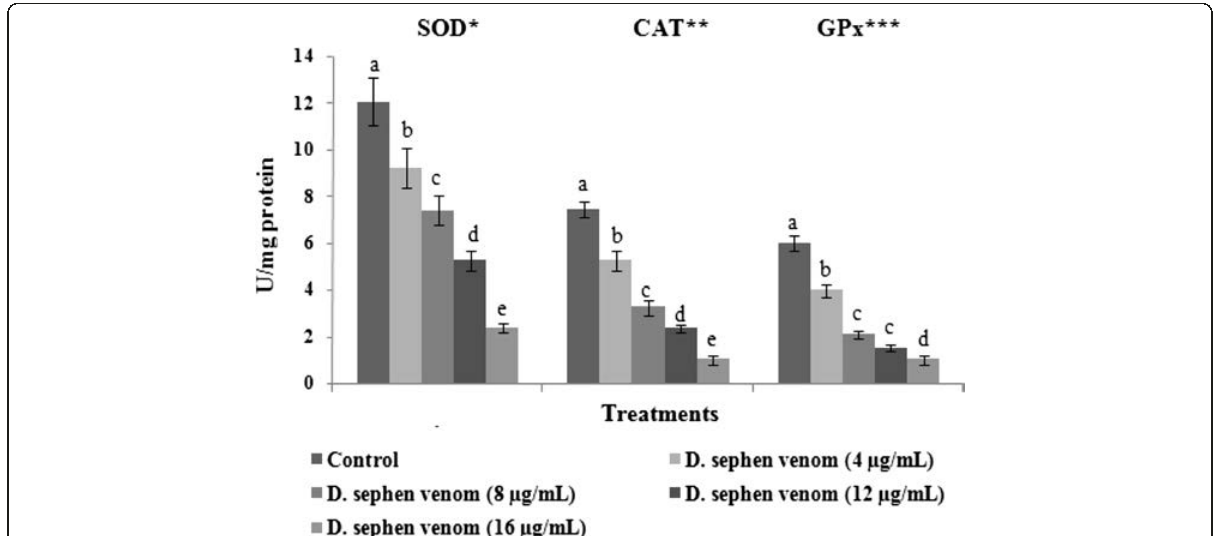
Fig. 4 Effect of D. sephen venom on cellular antioxidant status in HeLa cells. Bars represent the changes on the activities of SOD, CAT and GPx in control and venom treated cells. *Enzyme concentration required for 50 % inhibition of nitroblue tetrazolium reduction in one minute. ** μ mol of